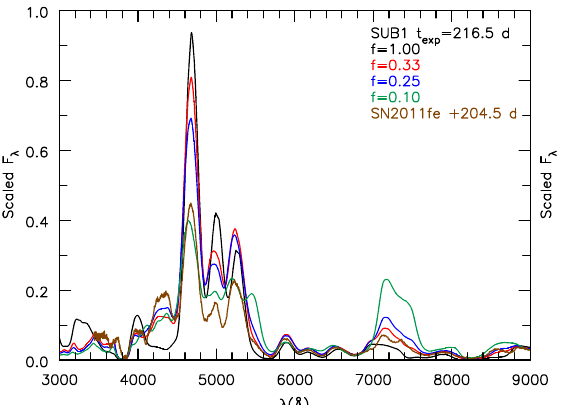
Figure 15. Illustration of a small section of the spectrum of a Ia SN showing the influence of clumping Figure 1. Comparison of SUB1 and CHAN models to SN2011fe. Flux values for SN2011fe have been scaled by 4.225 Then, all flux values were scaled by the same value that is of order unity. Data from SN2011fe are shown in brown and are 204.5d post B -band maximum. The which enhances recombination and hence reduces the ionization state of the gas. In the unclumped model, with f = 1, Fe III lines near 5000Å are too strong. Increasing the clumping (i.e., decreasing f ) lowers the ionization, thus improving the agreement. However, the emission feature near 7400 Å (a blend of Fe II , Ni II , and Ca II lines) is worse. The shape of the feature near 5000Å is also sensitive to the adopted Fe II photoionization cross-sections and updated calculations could also improve the